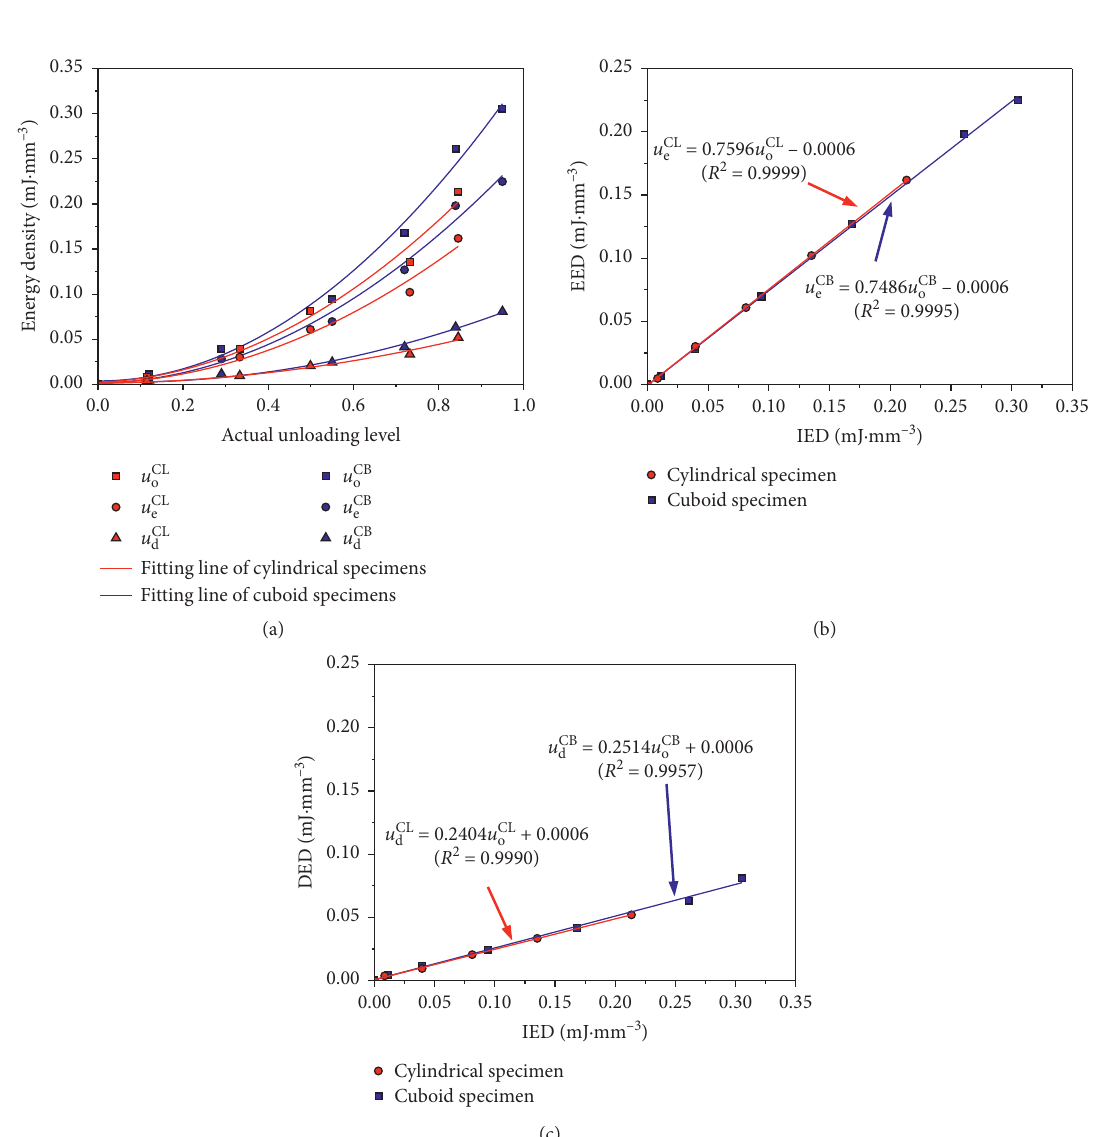
Figure 5: Comparison of energy characteristics inside cylindrical and cuboid specimens.